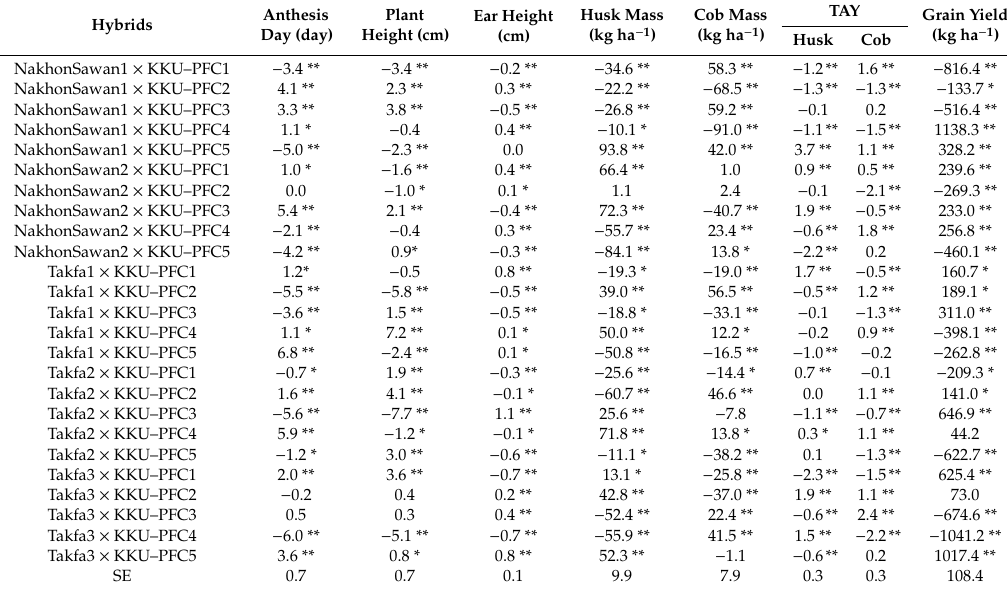
Table 7. Specific combining ability e ff ects (SCA) for agronomic traits, anthocyanin yield, and grain yield of hybrids across two